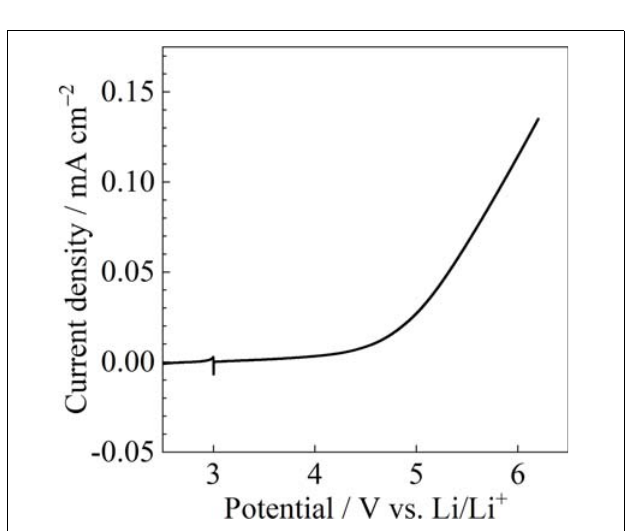
FIGURE 9 | LSV curve of SME/LiTFSA (Li/O = 0.17) at a scan rate of 10 mV s − 1 at 60 ◦ C.